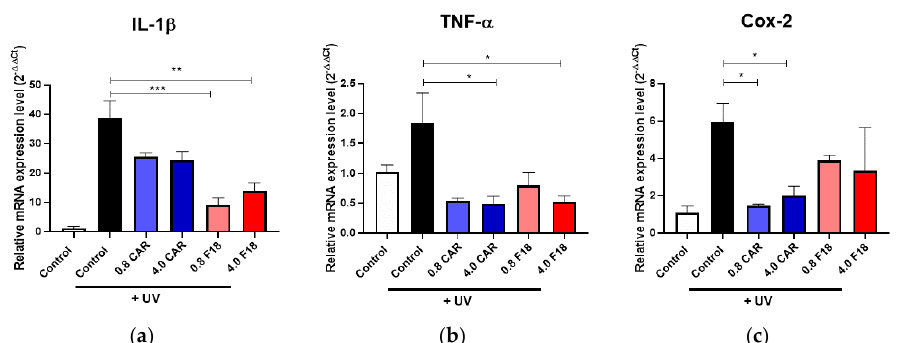
Figure 8. Effect of free drug or F18 on UV-mediated changes in the expression of proinflammatory genes IL-1 β ( a ), TNF- α ( b ), and COX-2 ( c ) in 3D human reconstituted skin by qPCR. qPCR results from 3D culture treated by UV 300 mJ/cm 2 and/or free carvedilol or F18. GAPDH was used as a normalization control for qPCR and the data are expressed as mean +/ − SE; n = 3. (***: p < 0.001; **: p < 0.01; *: p <0.05)).